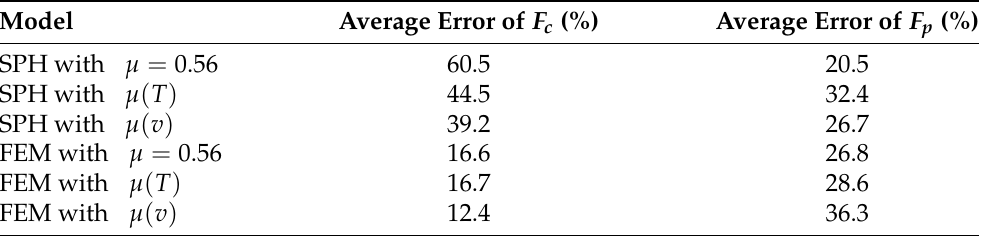
Table A2. Force prediction errors of SPH and FEM for Ti6Al4V using different friction